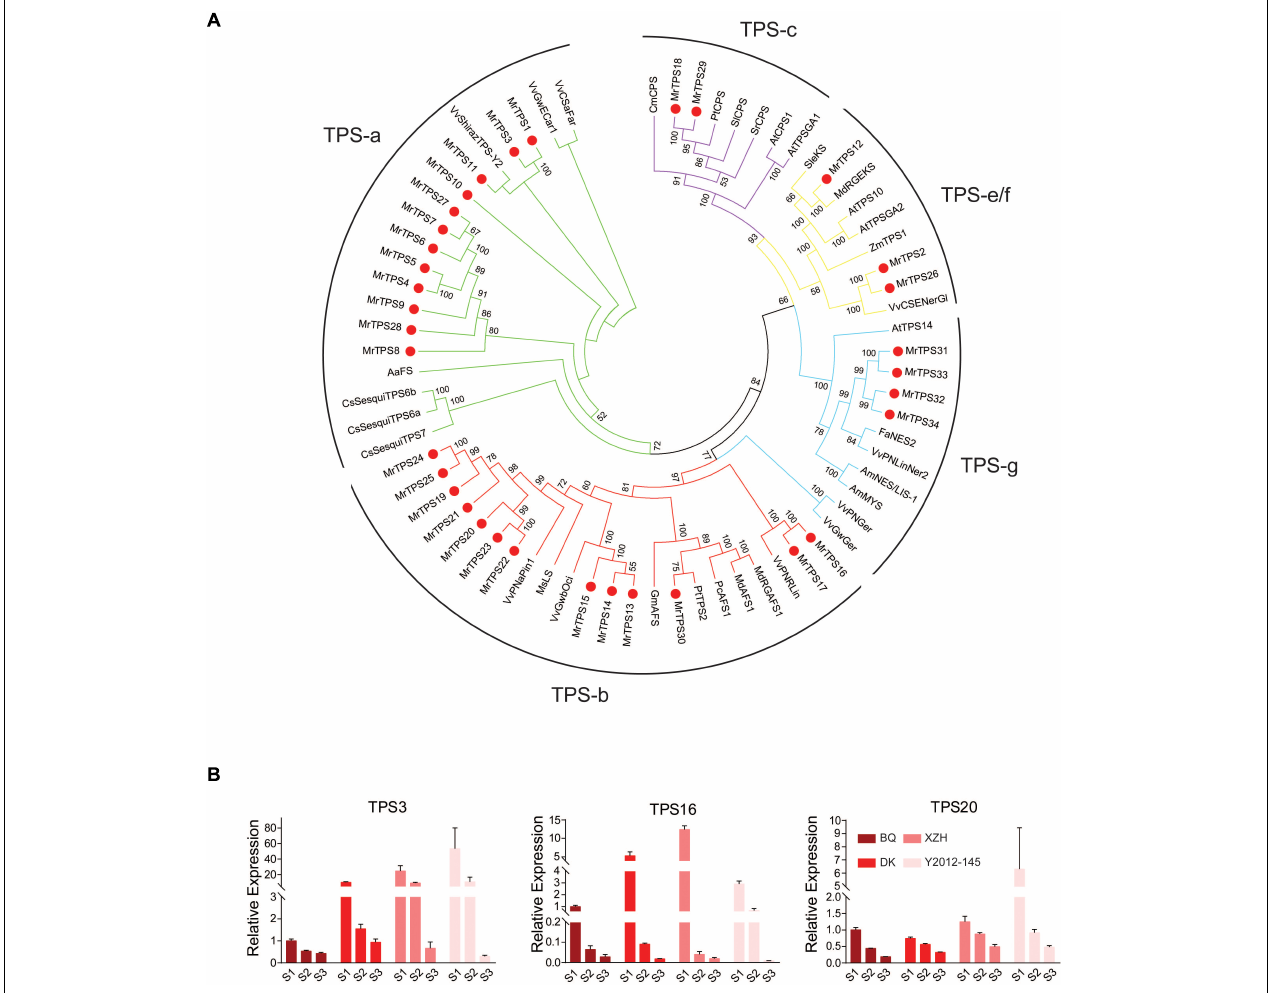
FIGURE 4 | Phylogenetic analysis of TPSs and their expression patterns in different cultivars. (A) Phylogenetic tree of TPS family members in different species. Neighbor-Joining method in MEGA was used to construct the phylogenetic trees with 1,000 bootstrap replicates. Red dots indicate the TPS members in red bayberry. Lines with different colors show the different subfamilies. Bootstrap values higher than 50 are shown. (B) qRT-PCR analysis of the three selected candidate TPS genes. Error bars indicate standard deviation of three biological replicates. S1, S2, S3 show the three fruit developmental stages.